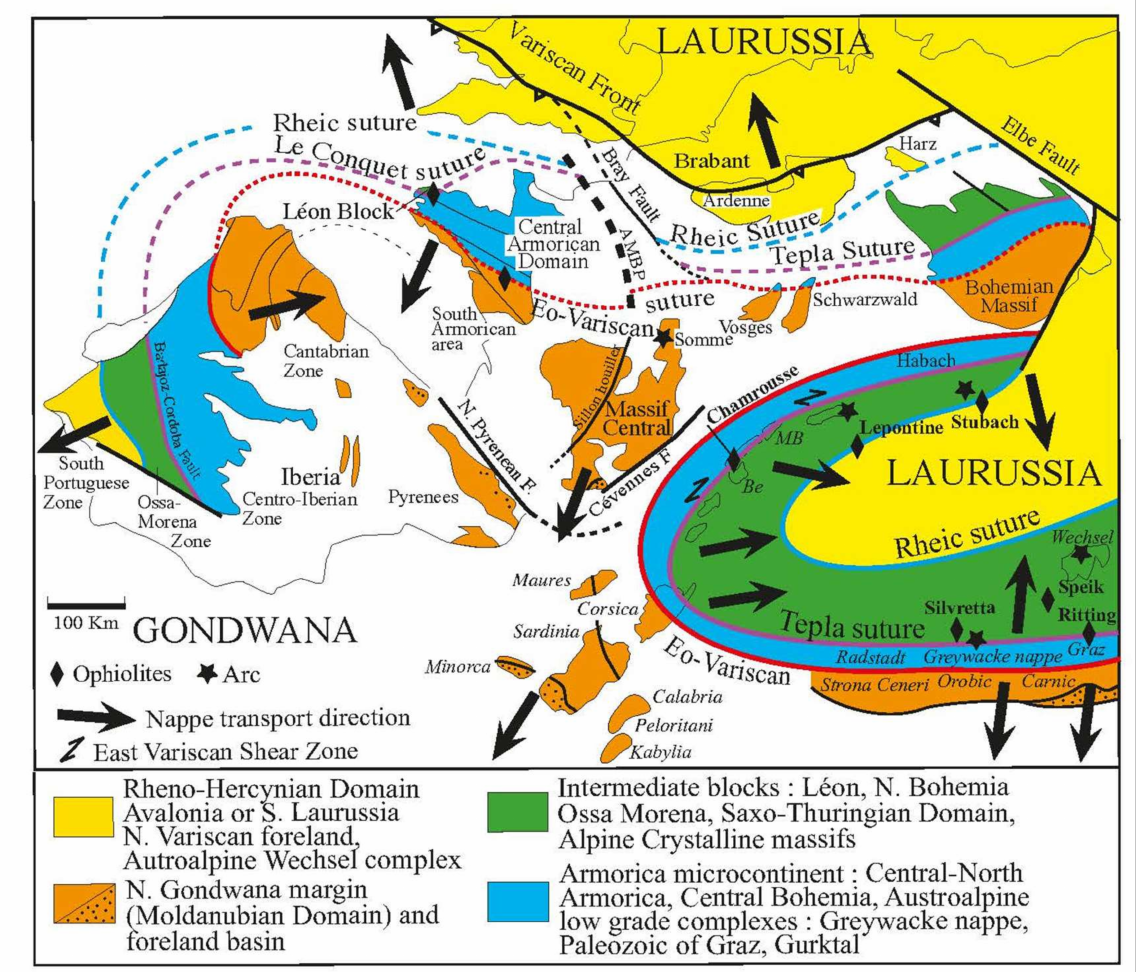
Figure 12. Palinspastic Early Permian reconstruction of the Variscan Alpidic orocline in the Western and Central Alps. The Sardinia-South Corsica-Maures and Southern Alps define the Moldanubian outer rim, including the southern foreland basins. The Western Alps External crystalline massifs, the Penninic massifs, and the unraveled Austroalpine units belong to the Armorica and Saxo-Thuringian Domains. The Alpidic orocline is cored by the Avalonian part of Laurussia. MB: Mont Blanc, Be: